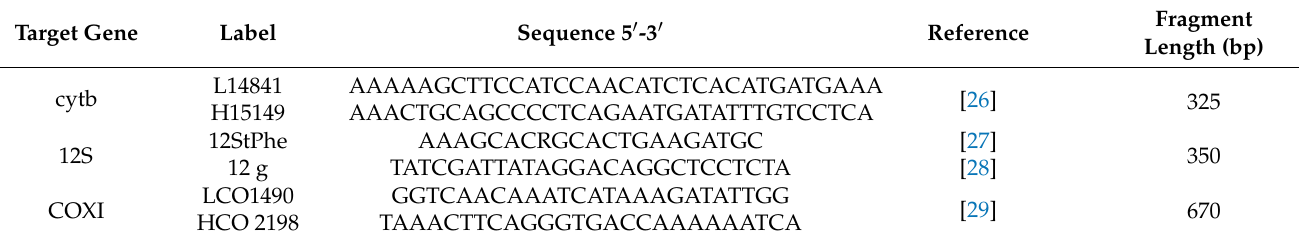
Table 2. Primers used for the molecular analyses of Chalcides ocellatus . Target